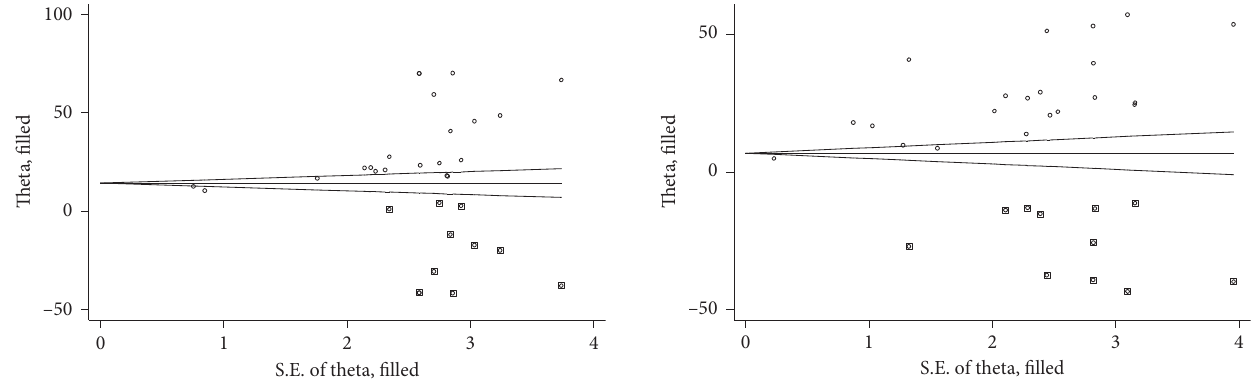
Figure 8: Trim and fill analysis based on NCEP/ATP III criteria. Figure 9: Trim and fill analysis based on IDF